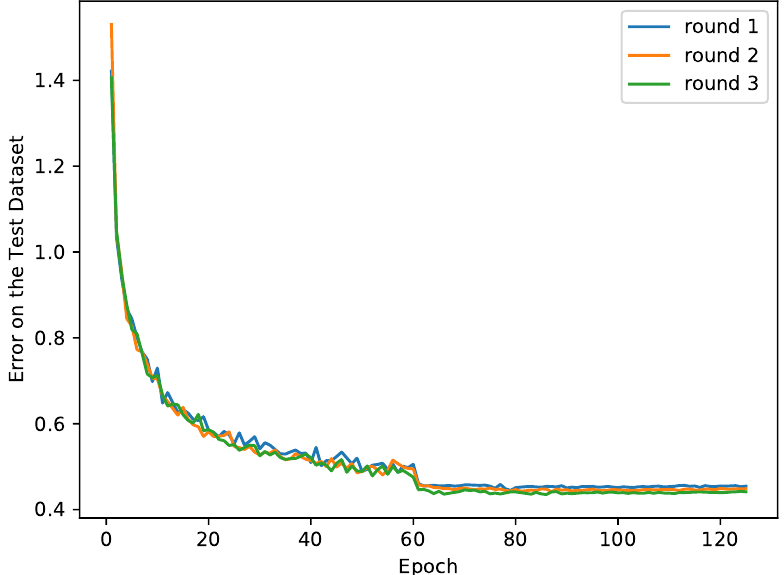
Figure 5. The error–epoch curves on the test dataset from three rounds of experiments with different random